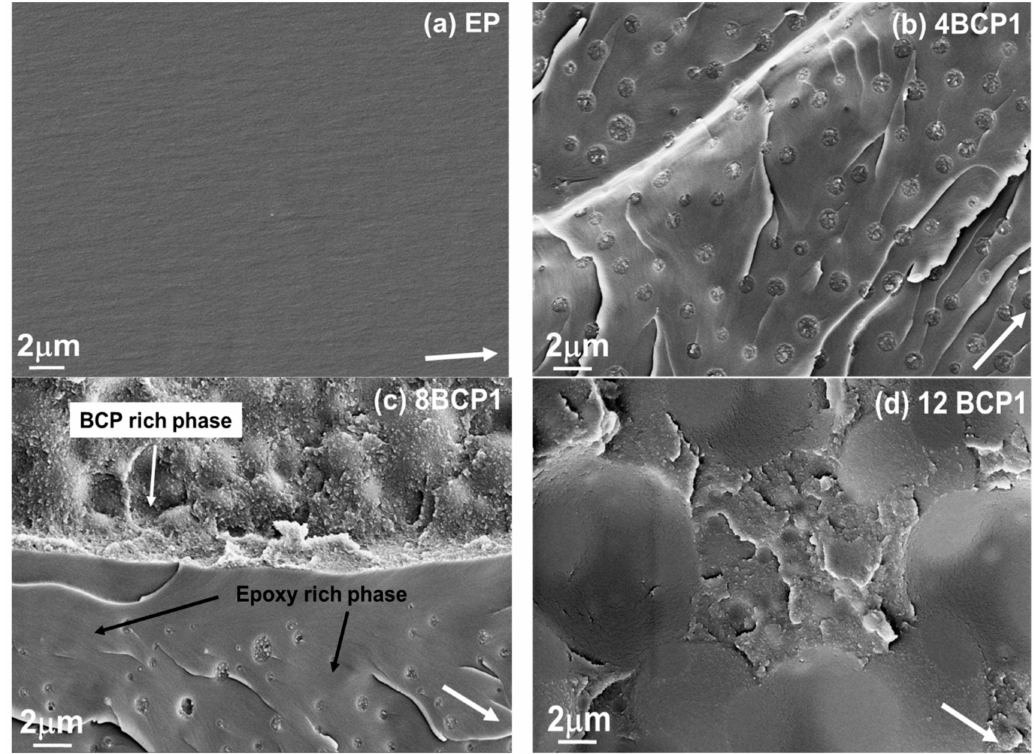
Figure 3. SEM micrograph showing the fracture surface of di ff erent epoxy systems modified with BCP1. White arrow indicates the direction of crack